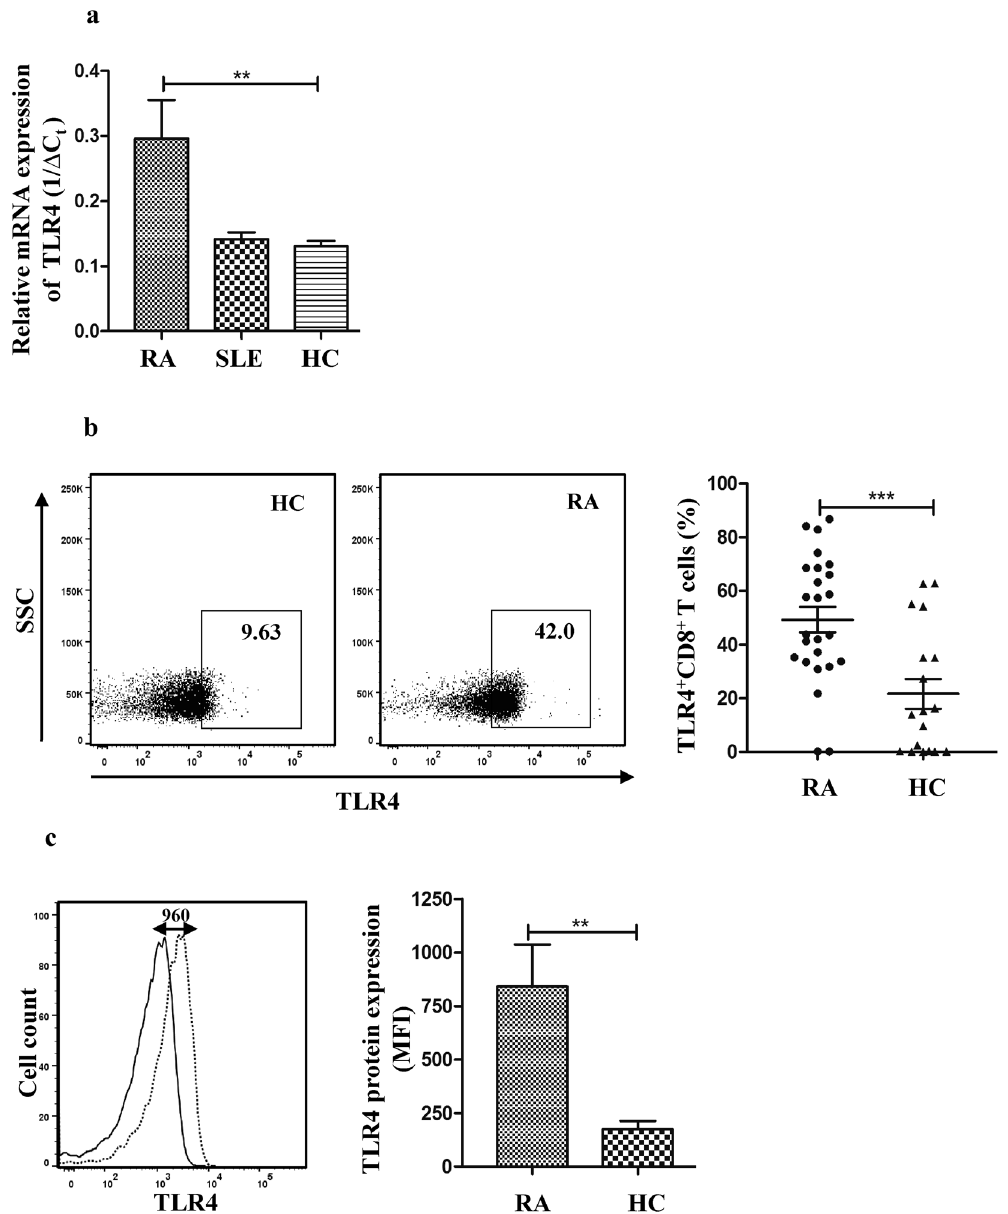
Figure 1. CD8 + T cells show increase TLR4 expression in RA patients. ( a ) Relative mRNA expression of TLR4 in peripheral CD8 + T cells was determined by qPCR from 45 RA patients, 9 SLE patients, and 42 healthy controls (HC). The qPCR C t values were normalized ( ∆ C t ) by subtracting the C t values of ß-actin from those of TLR4 and 1/ ∆ C t was plotted. ( b ) A representative FACS dot plot panel shows TLR4 expression by CD8 + T cell in a HC and RA patient. The box gate represents CD3 + CD8 + TLR4 + T cells. The graph represents percentages of CD3 + CD8 + TLR4 + T cells in our case (n = 25) - control (n = 18) cohort. ( c ) Histogram shows a comparative fluorescence distribution of TLR4 for CD8 + T cells from a single HC and RA patient. A shift in the fluorescence intensity represents an increase in TLR4 expression on CD8 + T cells of the RA patient. Solid line represents HC and dotted line represents RA. The bar graph represents median fluorescence intensities (MFI) of TLR4 protein expressed on CD8 + T cells in the case-control samples as in ( c ), and indicates significant increase in TLR4 expression in RA patients. Bars represent the mean ± SEM. ** p < 0.01, *** p <